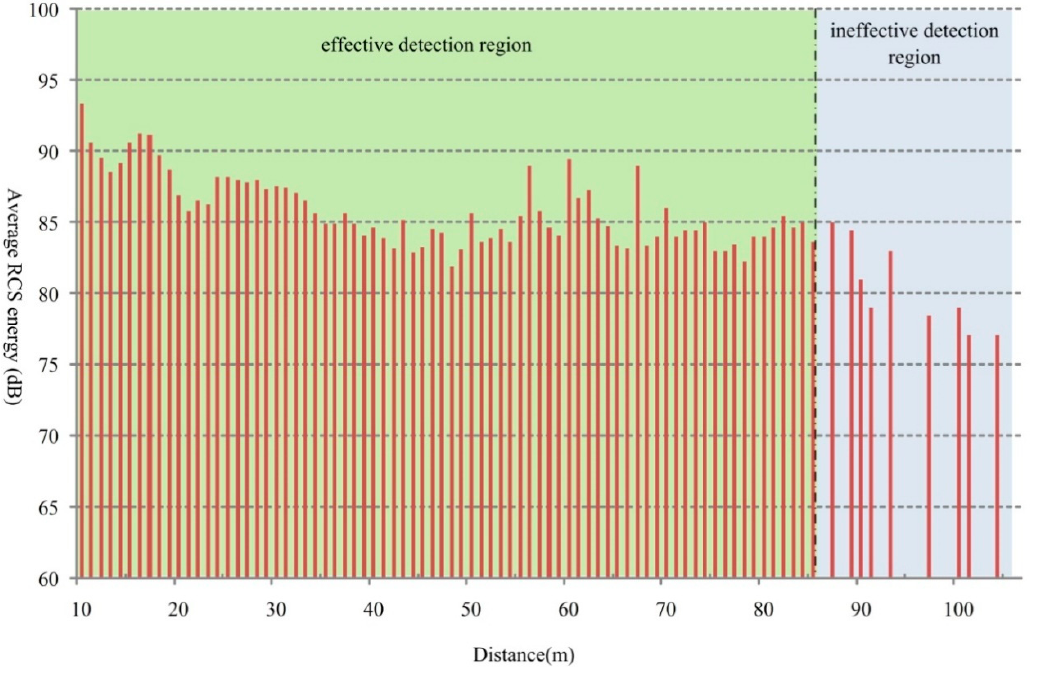
Figure 13. RCS energy distribution under different distances.